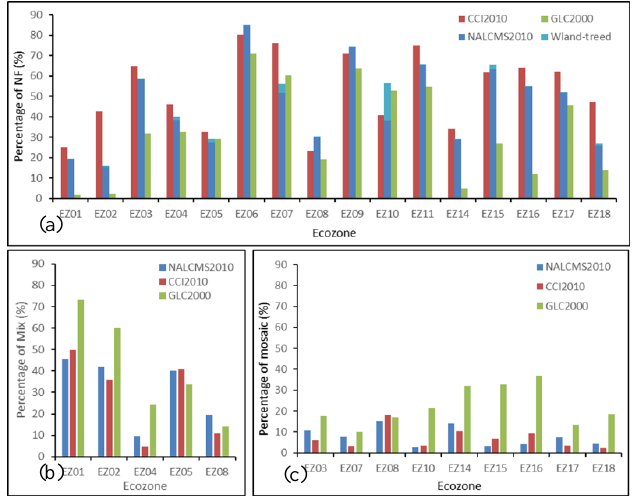
Figure 6. Producer ( a , c ) and user ( b , d ) accuracy (%) for needleleaf forest in the CCI (top) and GLC2000 (bottom) datasets relative to NALCMS at 10 km by 10 km pixel blocks.